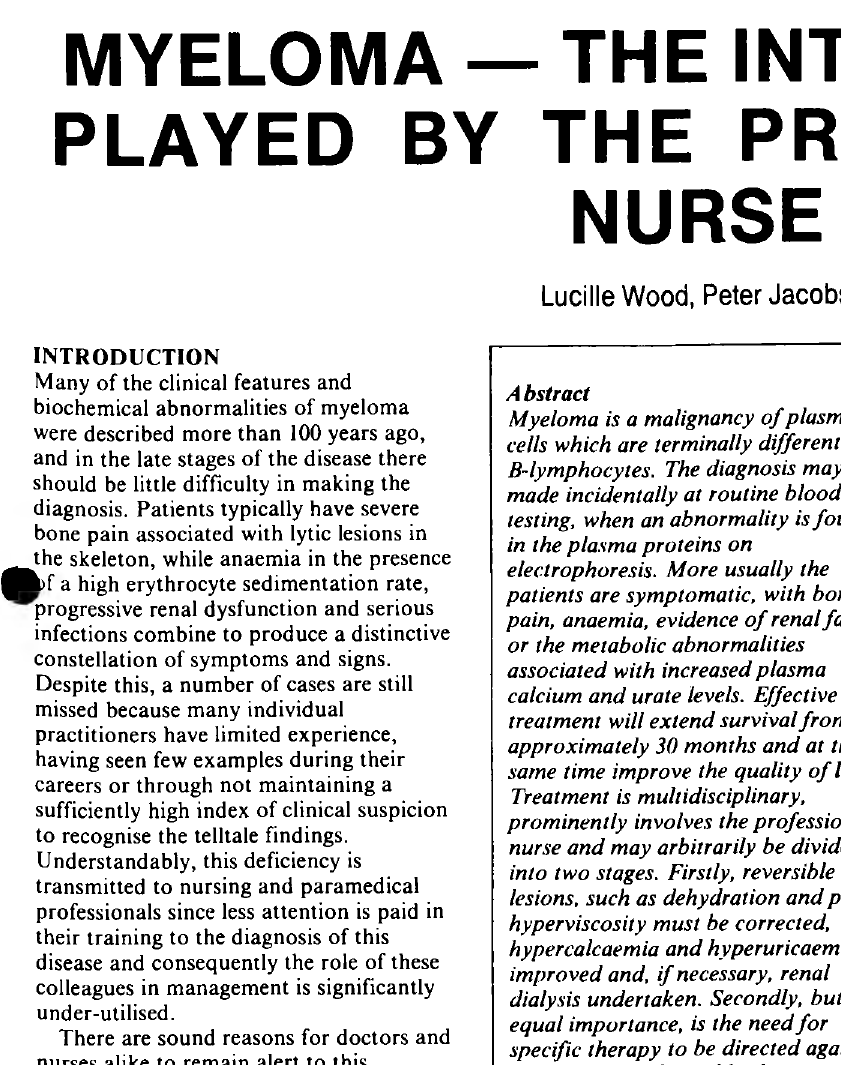
TABLE 1 Diagnostic Criteria in Myeloma